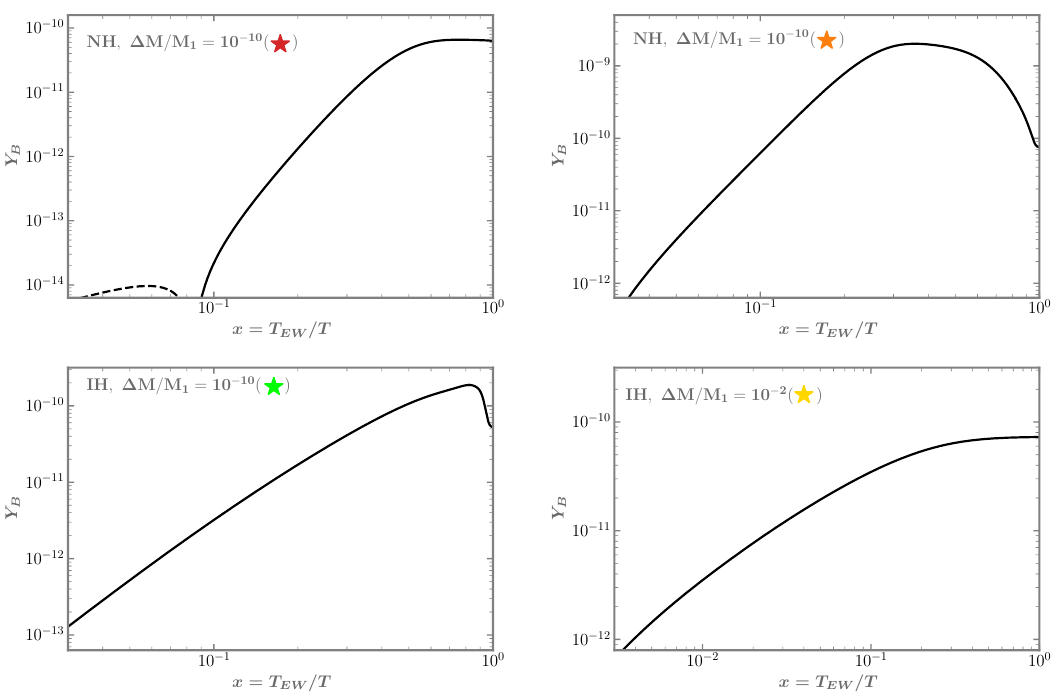
Figure 11 . Benchmark points from the numerical scan representing different qualitative behaviours of the BAU generation, see main text and figures 8 to